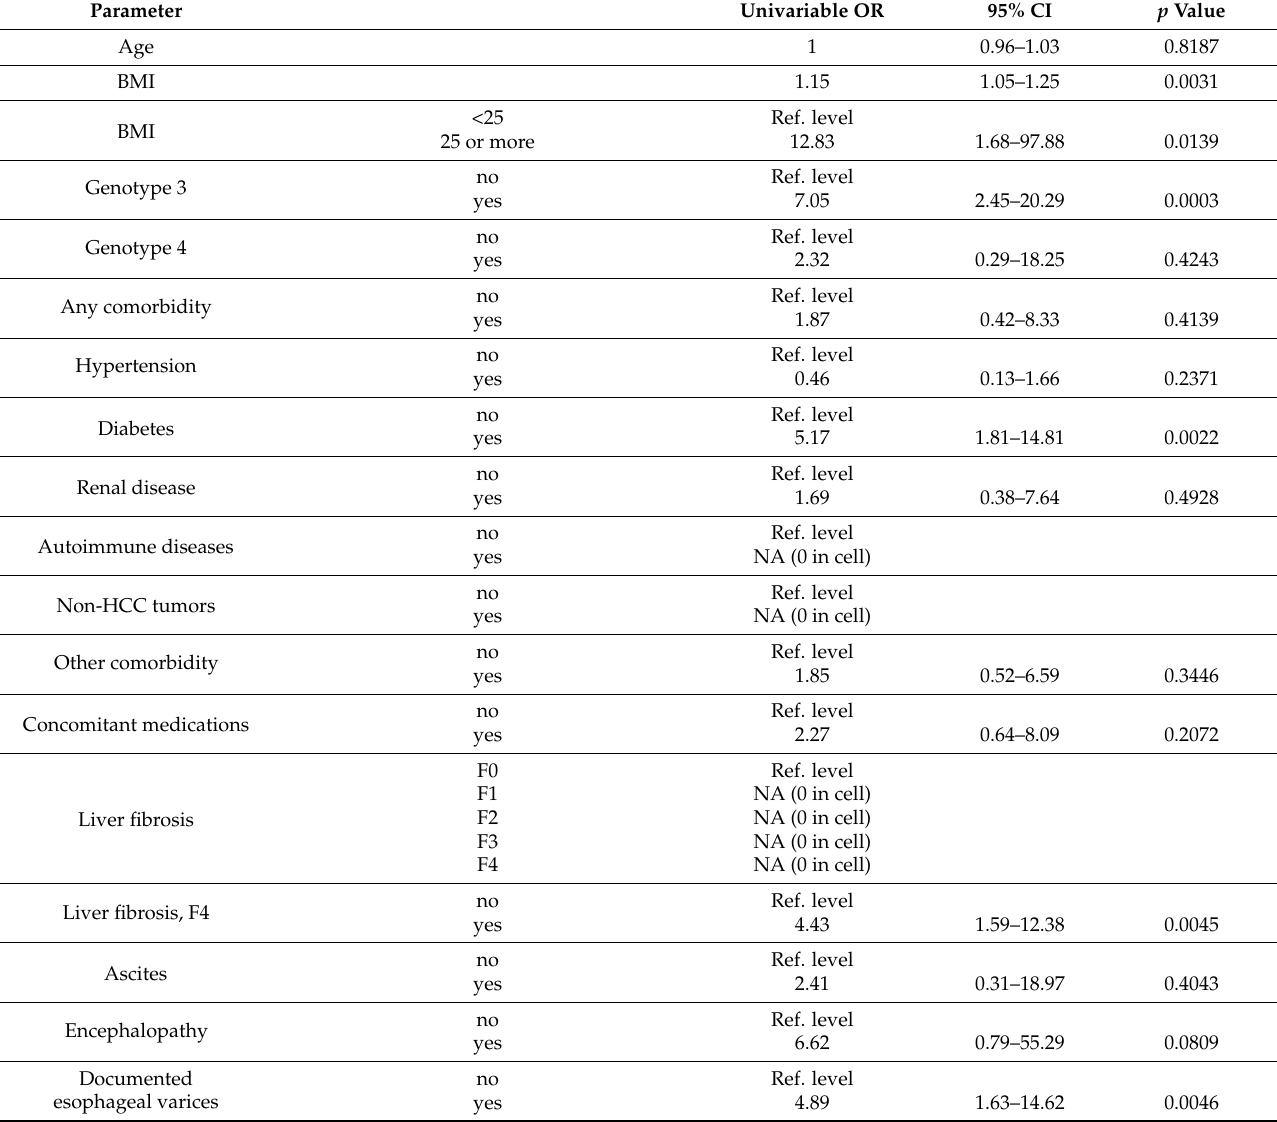
Table 6. Univariable Predictors of Non-Response to Antiviral